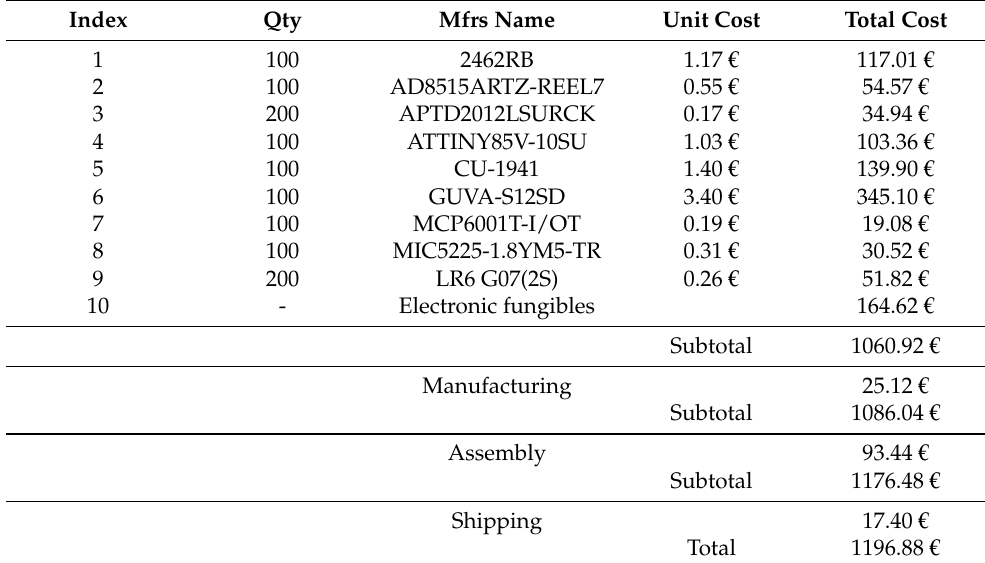
Table 4. Budget and total cost of manufacturing 100 UV dosimeter